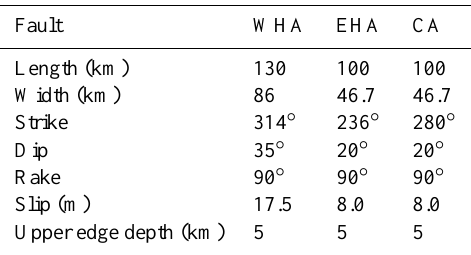
Table 1. Fault parameters for the three scenarios analysed in the paper.